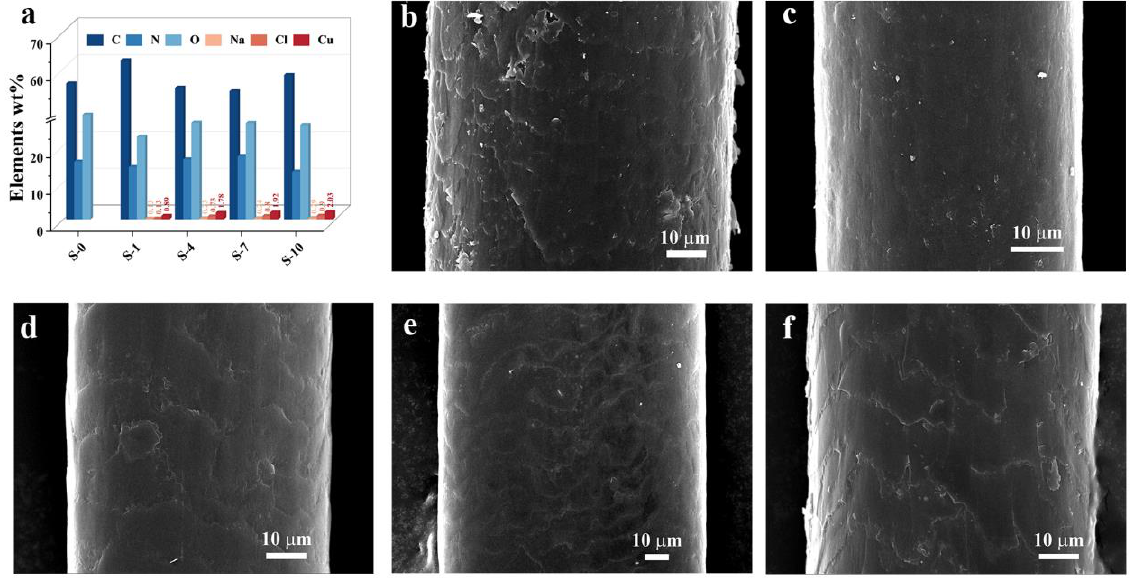
Figure 3. ( a ) Elements distributed on the hair surface; ( b – f ) FE-SEM images of the hair samples for S-0, S-1, S-4, S-7, and S-10.